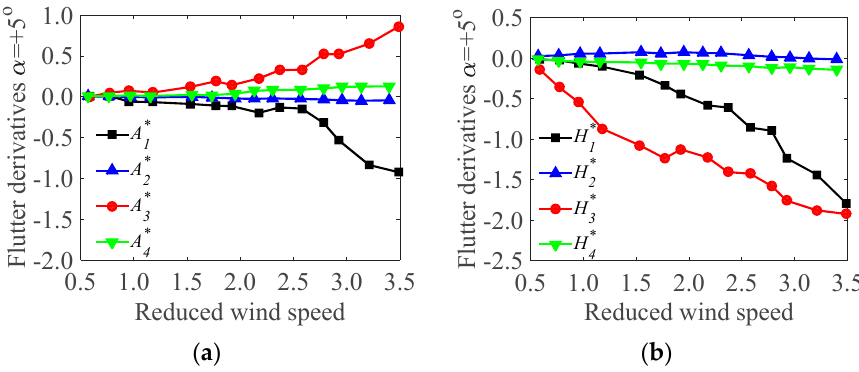
Figure 10. Comparisons of the flutter derivatives of the test model in the operation stage ( α = 5 ◦ ):